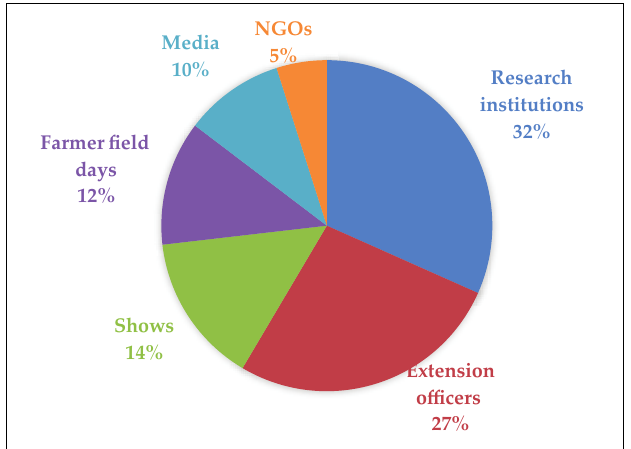
FIGURE 6 | Source of information of Lablab production.